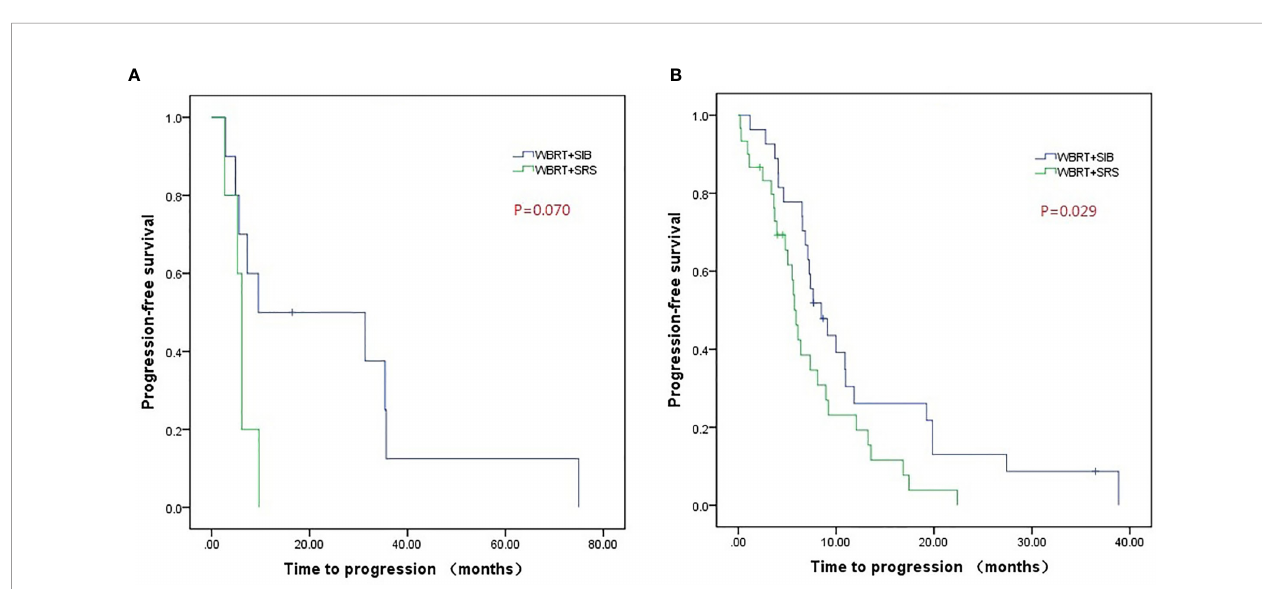
FIGURE 5 | Compared intracranial progression-free survival of WBRT + SRS and WBRT + SIB in patients with stable extracranial disease (A) or active extracranial disease (B)